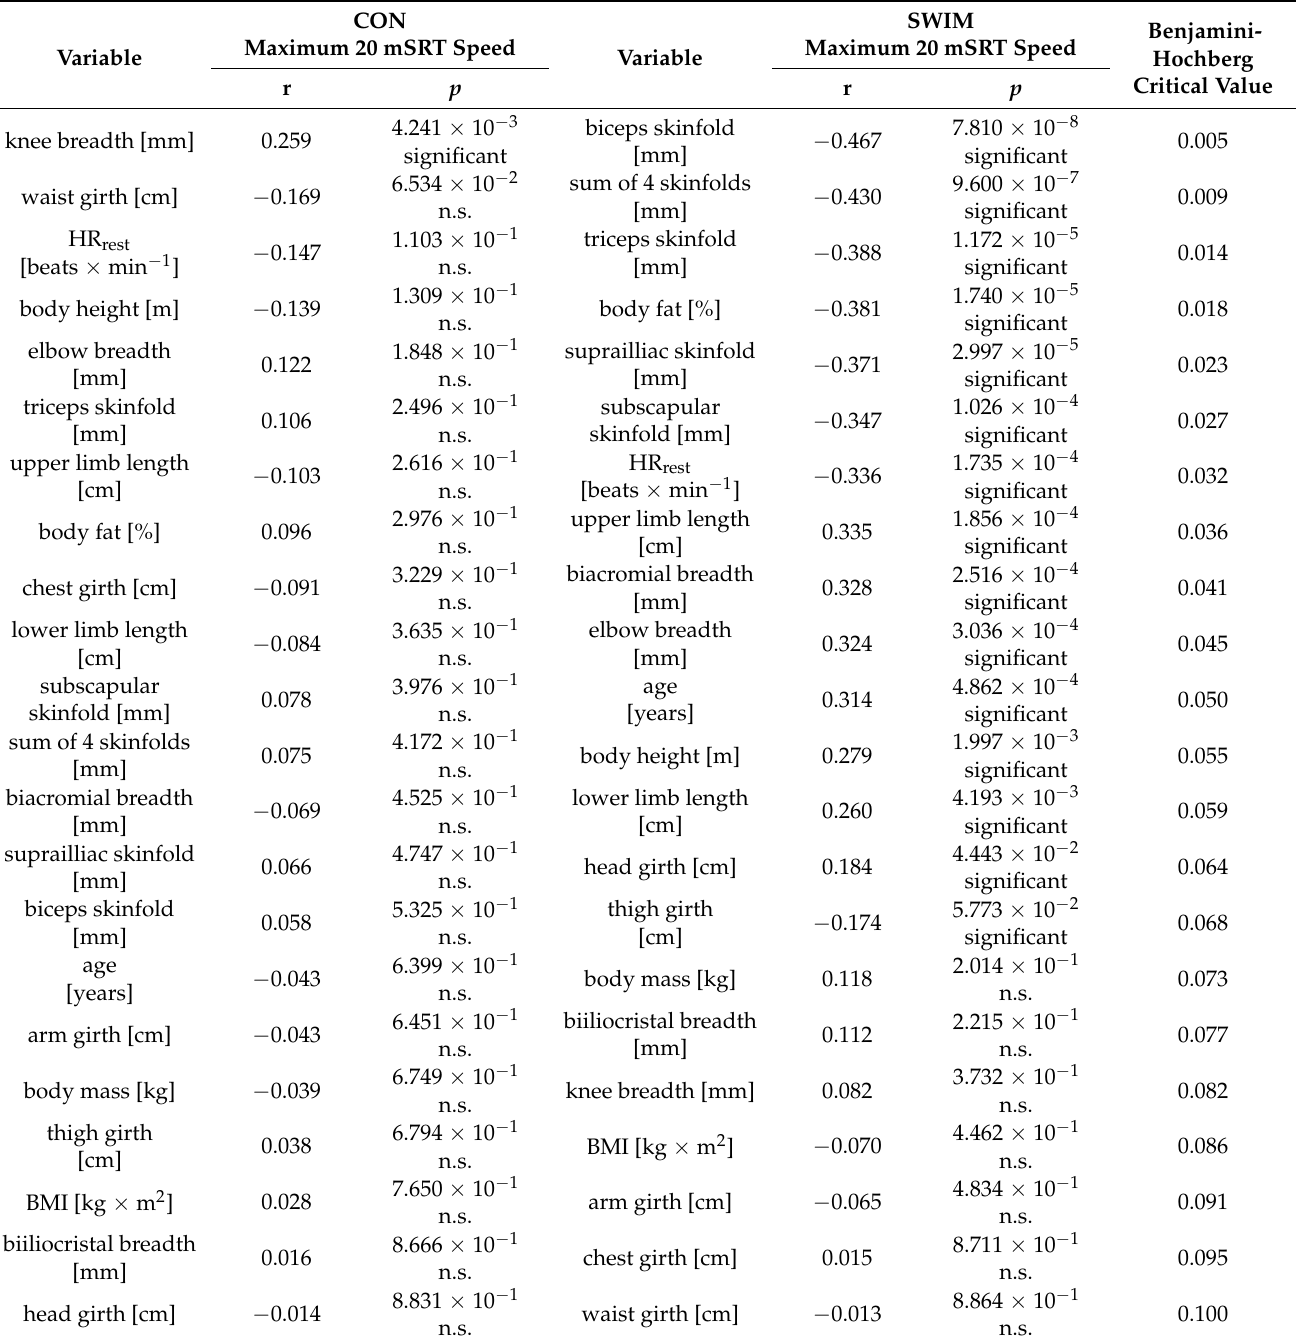
Table 4. Pearson’s correlation coefficients between the maximum oxygen uptake values (VO 2 max) predicted on the basis of 20 mSRT and investigated biological variables in the control group (con; n = 120) and the experimental group (swim; n = 120) with adjustments for the false discovery rate of